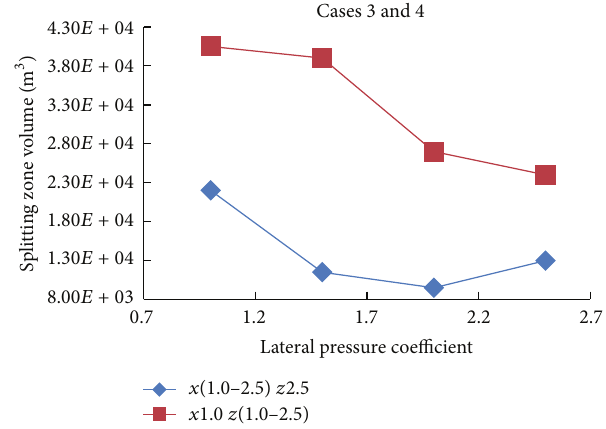
Figure 20: 𝛽 versus lateral pressure coefficient in cases 3 and 4 .